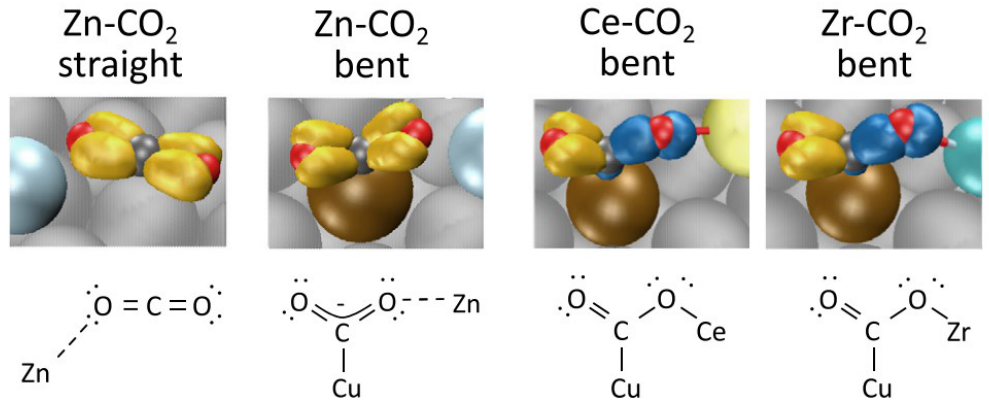
Figure 3. Wannier orbitals of [CO 2 ] − , [HCOO] − (formate), HCOOH (formic acid), and CO 2 bound straight to Zn, bent to Zn, Ce, and Zr in the surface model. Reprinted with permission from [29]. Copyright (2018) Elsevier.